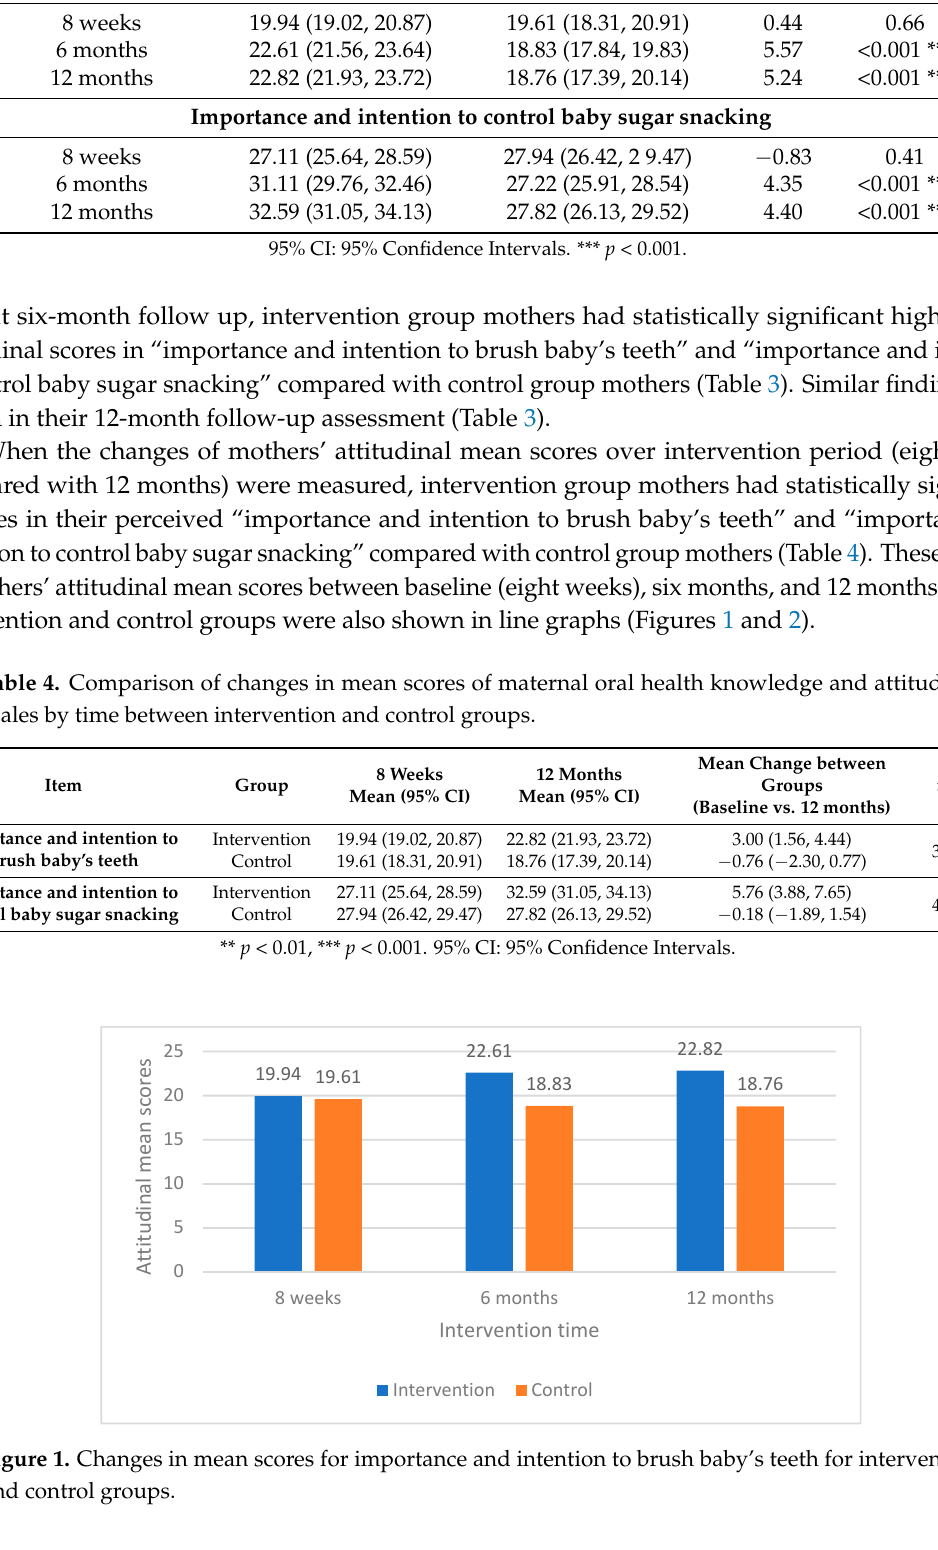
Table 3. Comparison of maternal oral health related attitudes at baseline, 6 months, and 12 months between intervention and control group mothers.